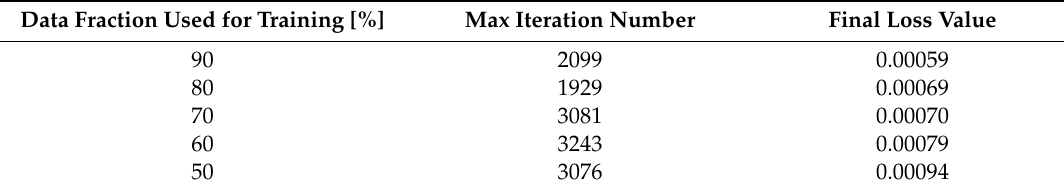
Table 4. The maximum number of iterations and corresponding loss values calculated using the last two iterations when training the ANN on di ff erent fractions of training data with respect to the validation data.